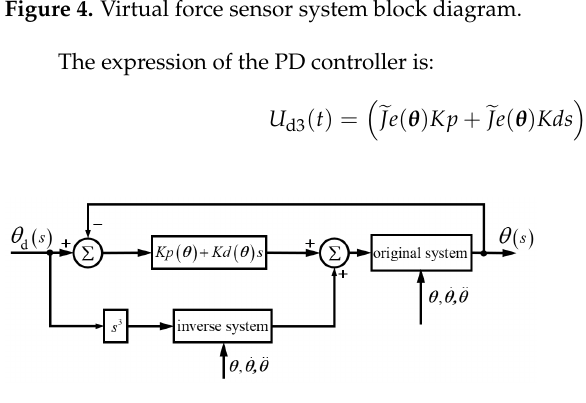
Figure 4. Virtual force sensor system block diagram.